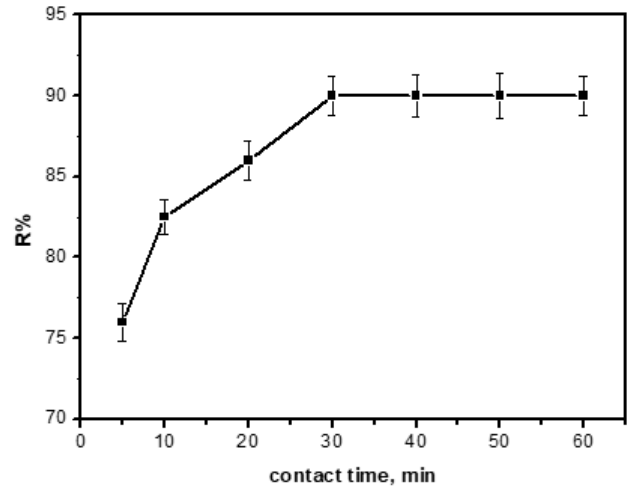
Figure 6. E ff ect of contact time on the e ffi ciency of removal of Ni(II) Figure 6. Effect of contact time on the efficiency of removal of Ni(II) ions.